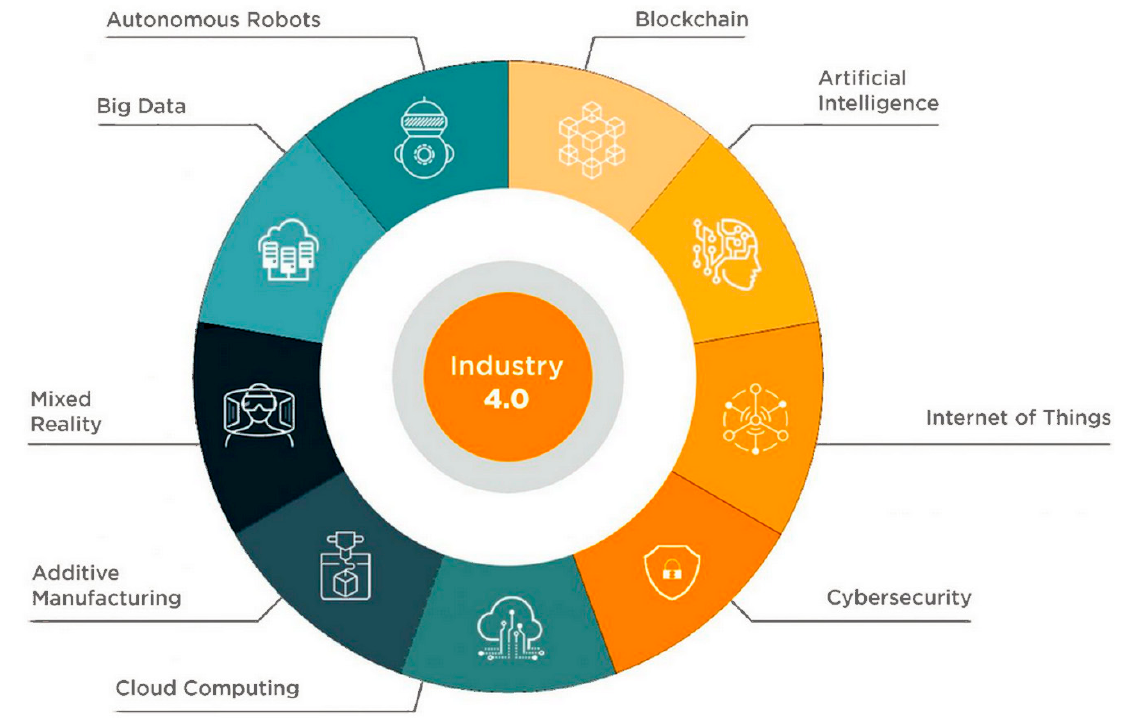
Figure 4. Industry 4.0 and the elements of digitalization [38].